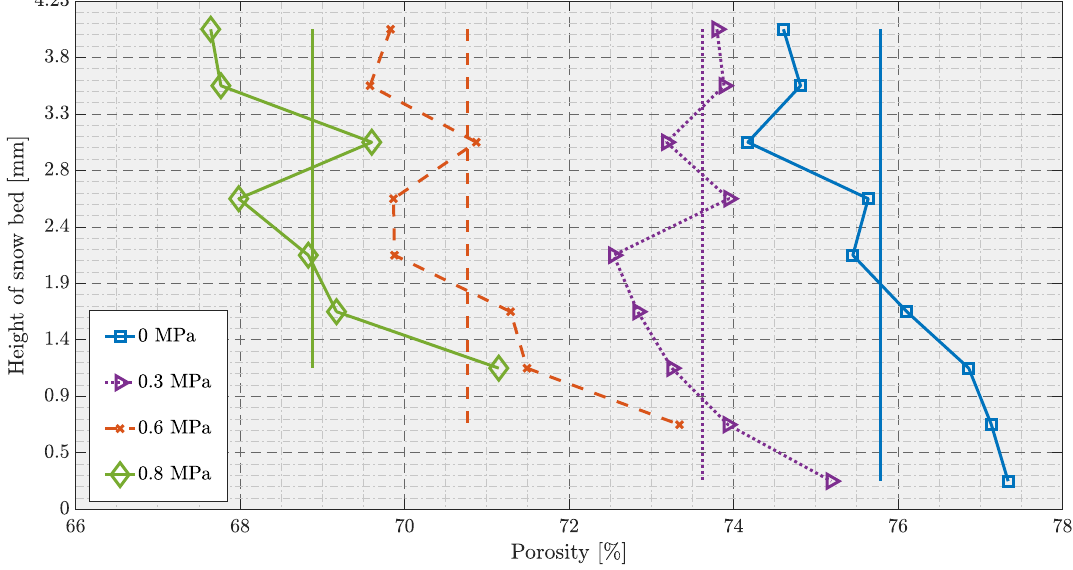
Figure 8. Porosity distributions for the discretized sections of the investigated snow volume.